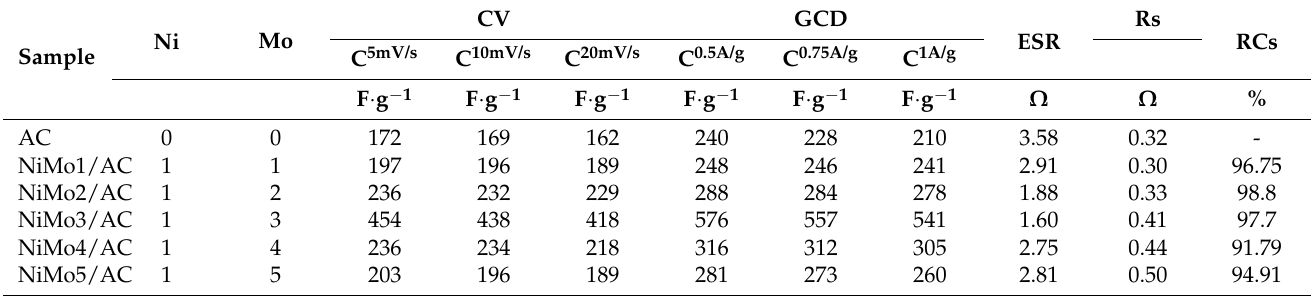
Table 3. The specific capacitance values are derived from CV and GCD. Capacitance retention RCs after 4000 cycles at 4 A g − 1 . EIS is used to calculate the equivalent series resistance (ESR).